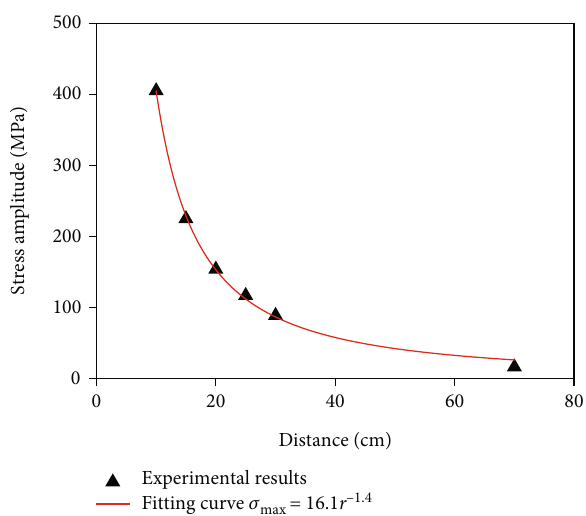
Figure 10: Attenuation of stresses with